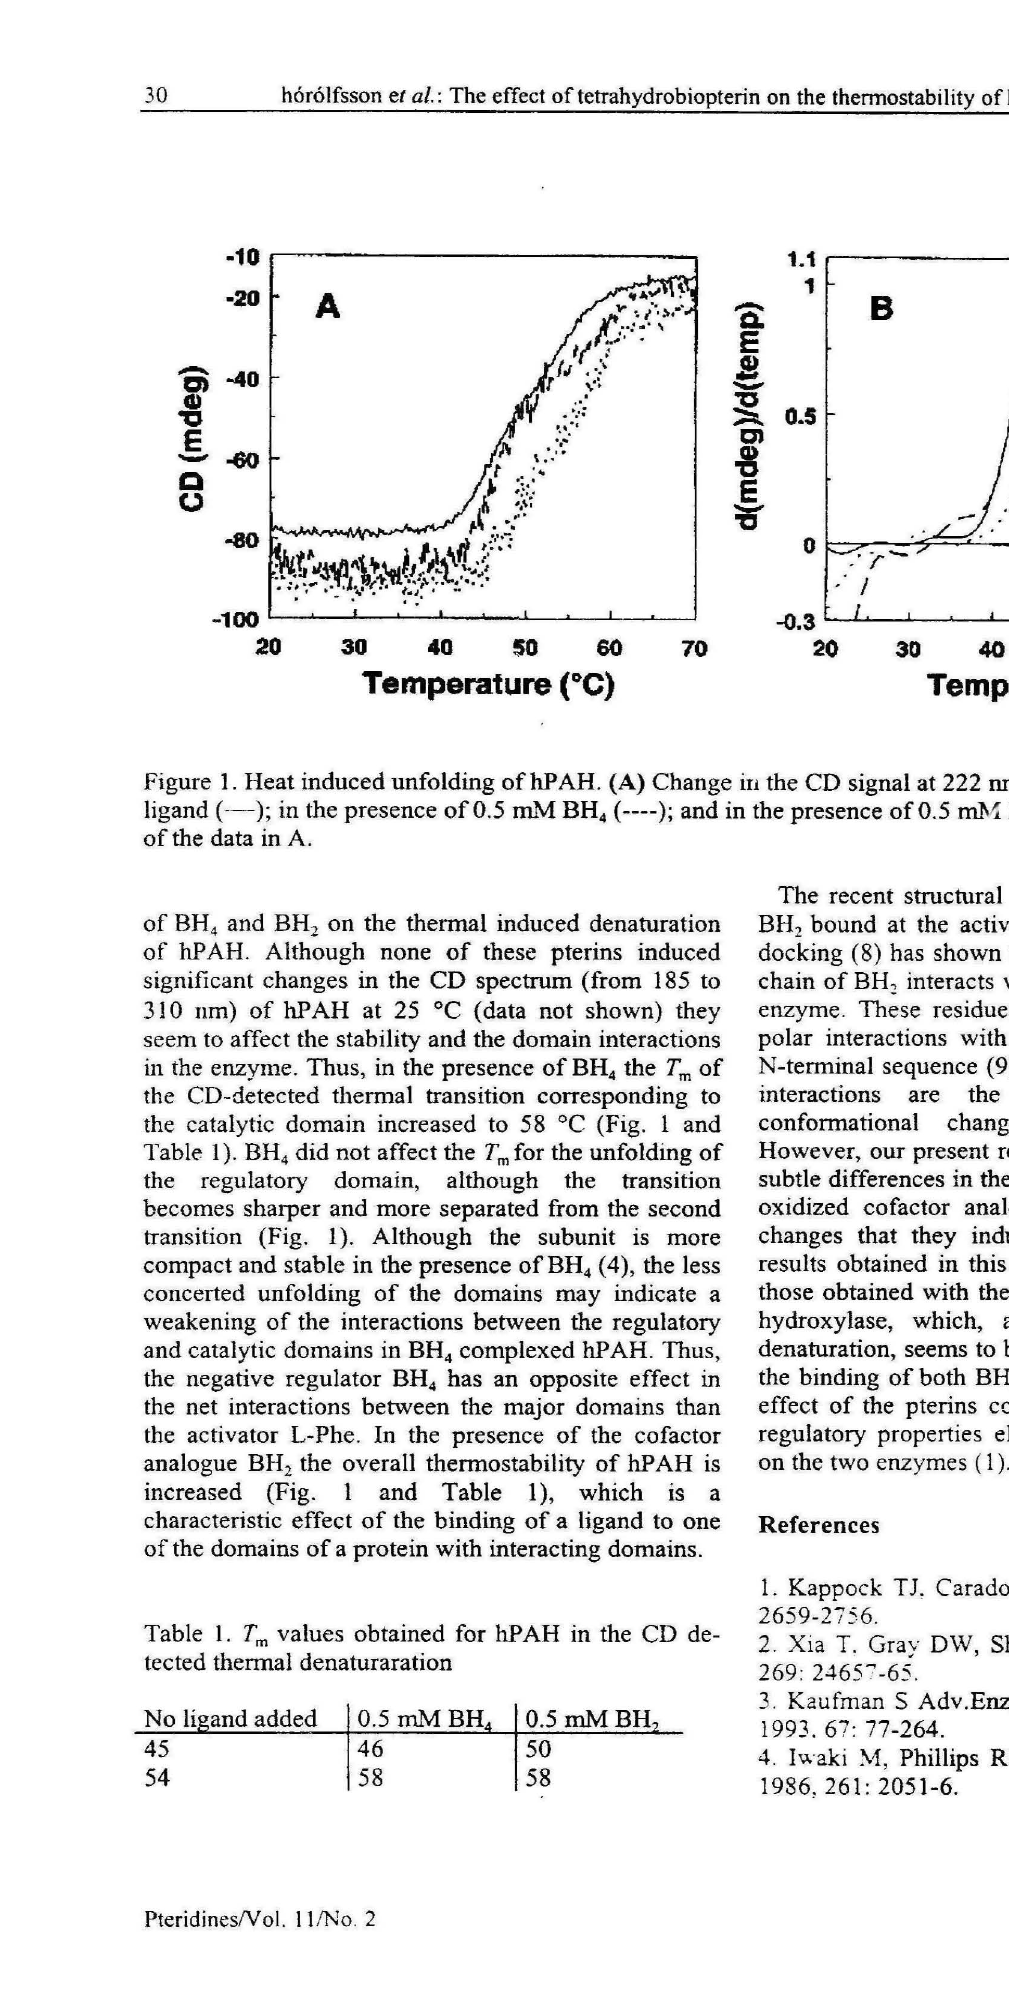
Table 1. Tm values obtained for hPAH in the CD de tected thermal denaturaration No Ii and